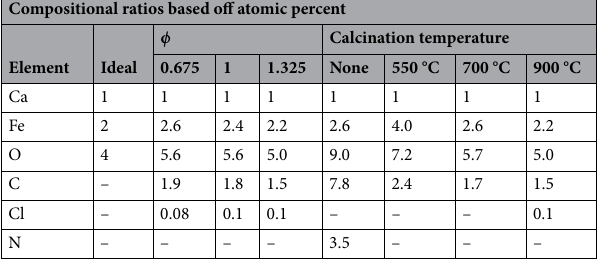
Table 1. Compositional ratios, reported as XPS-derived atomic percentages normalized to the Ca concentration, of primary and trace elements in pCFO across ϕ (calcination temperature = 900 °C) and across calcination temperature ( ϕ = 1.325).